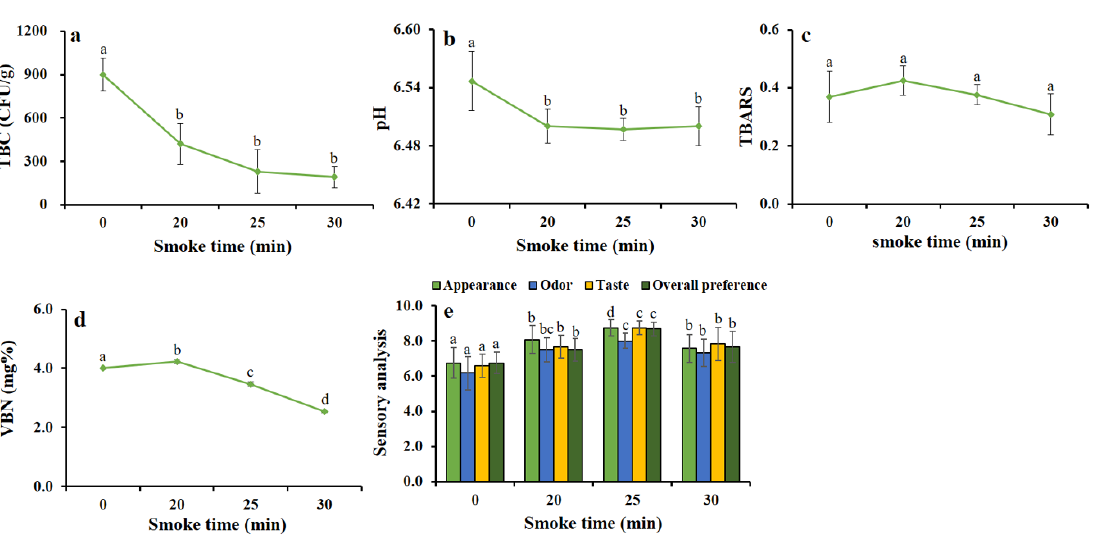
Figure 4. Different smoking times on the improvement of ( a ) TBC (CFU/g), ( b ) pH, ( c ) TBARS, ( d ) VBN (mg%), and ( e ) sensory evaluation of hot smoked HDPS. Data represent the mean ± std of 10 observations, where groups not sharing a letter are expressed as significantly different ( p < 0.05).